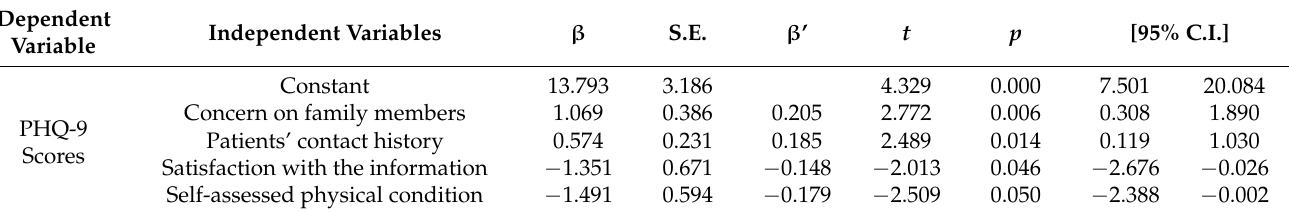
Table 5. Stepwise regression analysis of the factors of depression due to COVID-19.